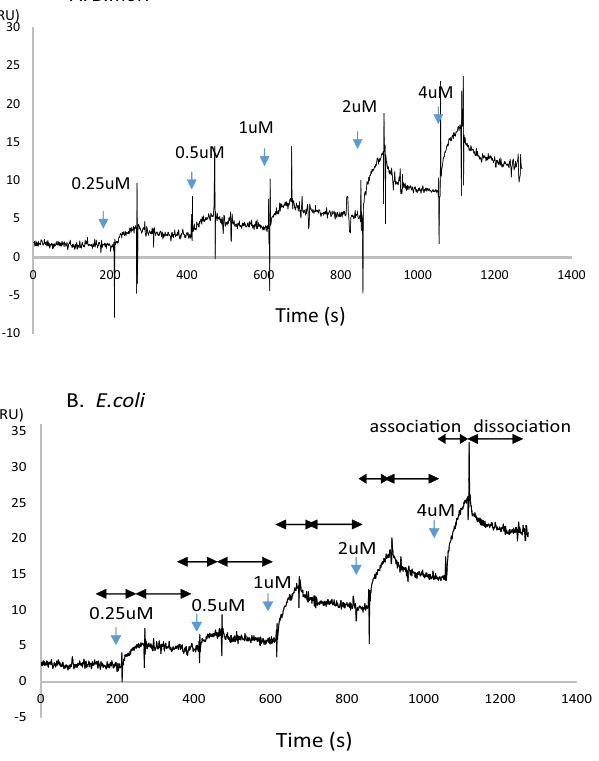
Figure 5. Sensorgrams of specific binding of serially diluted ligands to immobilized sRAGE on an SA sensor chip. Sequentially diluted ligands (0.25, 0.5, 1, 2, and 4 μ M) were injected at the points indicated by arrows. ( A ) sRAGE expressed in B. mori . ( B ) sRAGE expressed in E. coli . Ligand (F-AGEs) diluted with running buffer (PBS) was injected over flow cells at a flow rate of 30 μ L/min to allow 1 min association, and the flow cell was allowed 2 min for dissociation using a single-cycle kinetics program. Two reference curves (one curve derived from the injection of buffer only, and one curve derived from nonimmobilized sRAGE) were subtracted from the binding curve to exclude the effects of nonspecific binding. The dissociation constant of ligands to sRAGE was calculated based on the 1:1 (Langmuir) binding